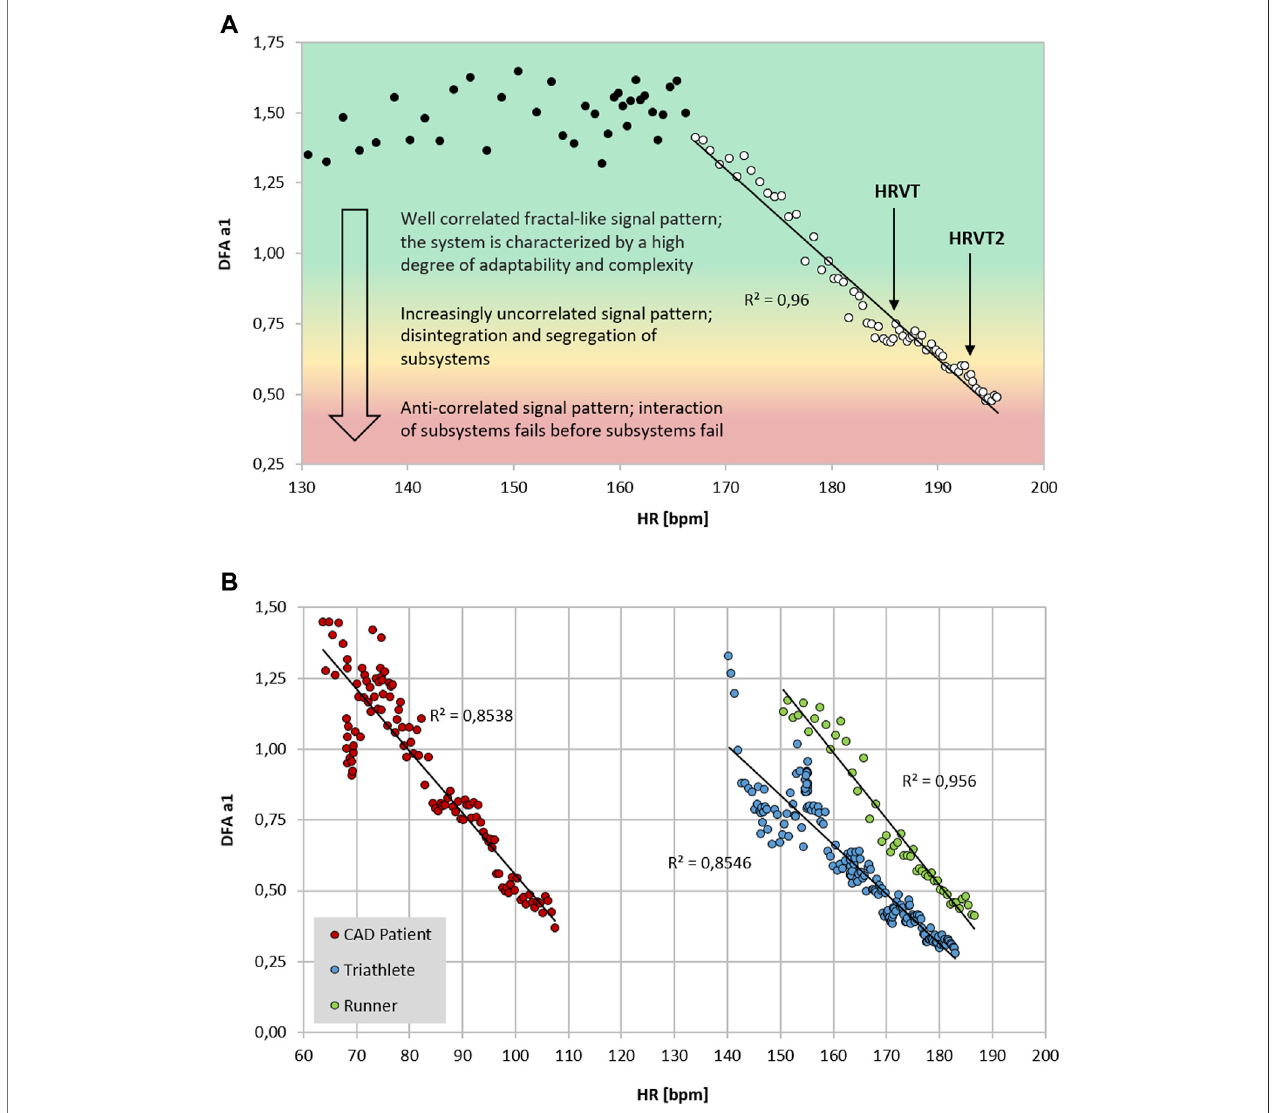
FIGURE 1 | (A) DFA a1 vs . HR of a 26-year-old male runner with a VO 2MAX of 72 ml/kg/min, HR at VT1 of 183 bpm and HR of 192 bpm at VT2 performing an incrementaltreadmillramptest, including aqualitative description ofthesignalpattern;datarecordedwithan ECG (MP36; Biopac SystemsLtd., Essen,Germany)(data fromRogersetal.,2021a;Rogersetal.,2021c).DataprocessedinKubiosHRVPremiumsoftware(Version3.5)usingautomaticcorrectionmethod(artifactpercentage: < 5%). Shading indicates a 3 zone exercise intensity model de fi ned by DFA a1 thresholds. (B) DFA a1 vs . HR of three participants during incremental exercise ramps (data from Rogers et al., 2021f; Rogers et al., 2022a; Rogers et al., 2021a respectively). Data processed in Kubios HRV Premium software (Version 3.5) using automatic correction method (artifact percentage: < 5%). Red circle: 59-year-old male with stable coronary artery disease (CAD), beta blocker usage and a VO 2MAX of 25 ml/kg/min,HRatVT1of83 bpmandHRatVT2of109 bpmperforminganincrementalcyclingramptest;datarecordedwithanECG(VISTAHolterNOVACOR,Rueil, Malmaison, France). Blue circle: 23-year-old female triathlete with a VO 2MAX of 60 ml/kg/min, HR at LT1 of 154 bpm and HR at LT2 of 165 bpm performing an incremental cycling stage test; data recorded with Polar H10 chest strap (Polar Electro Oy, Kempele, Finland). Green circle: 19-year-old male runner with a VO 2MAX